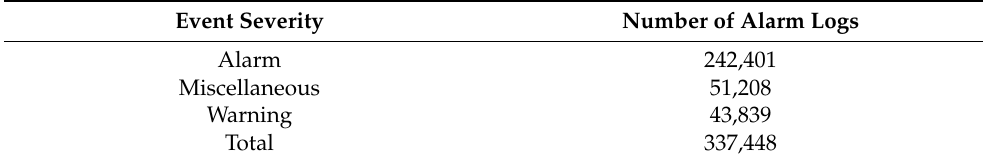
Table 2. Breakdown of SCADA alarm logs per severity.